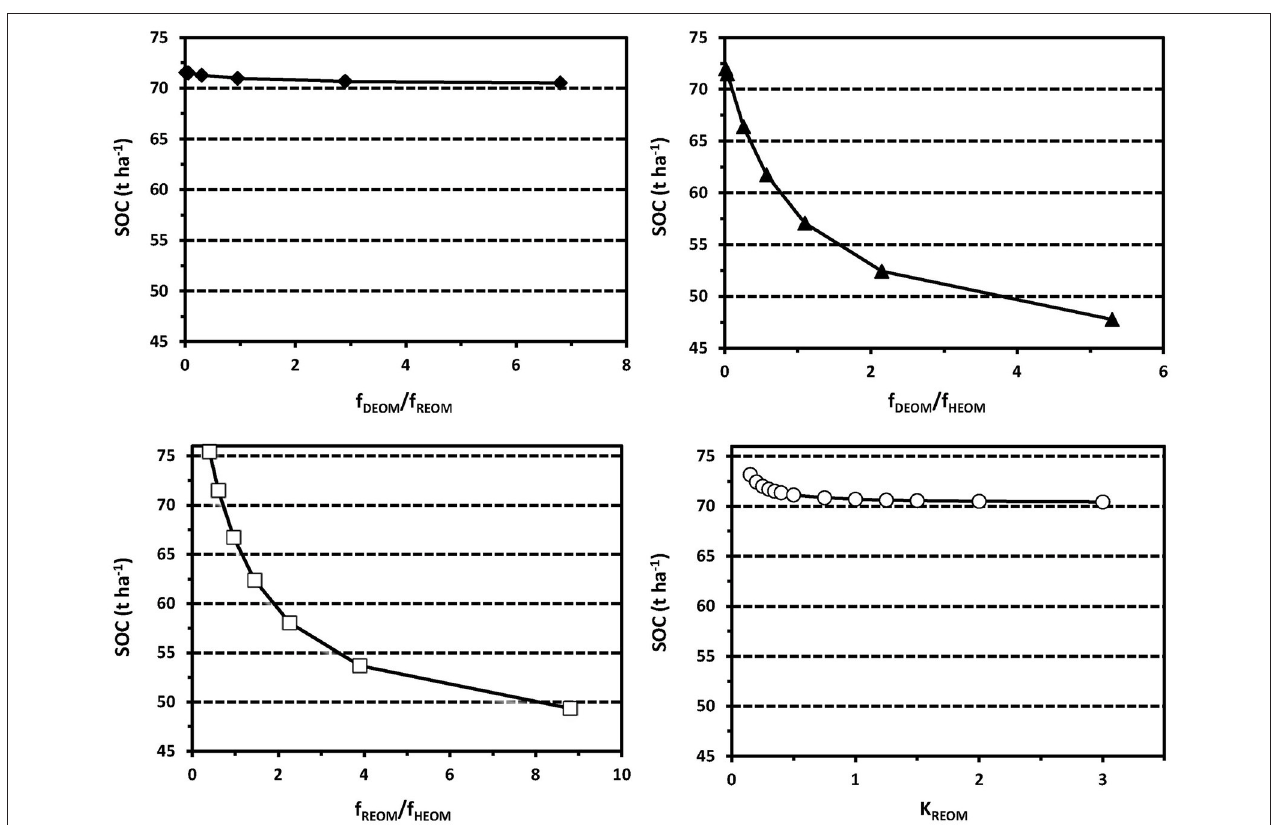
FIGURE 2 | Roth C EOM pool parameters sensitivity analysis for household waste compost amended